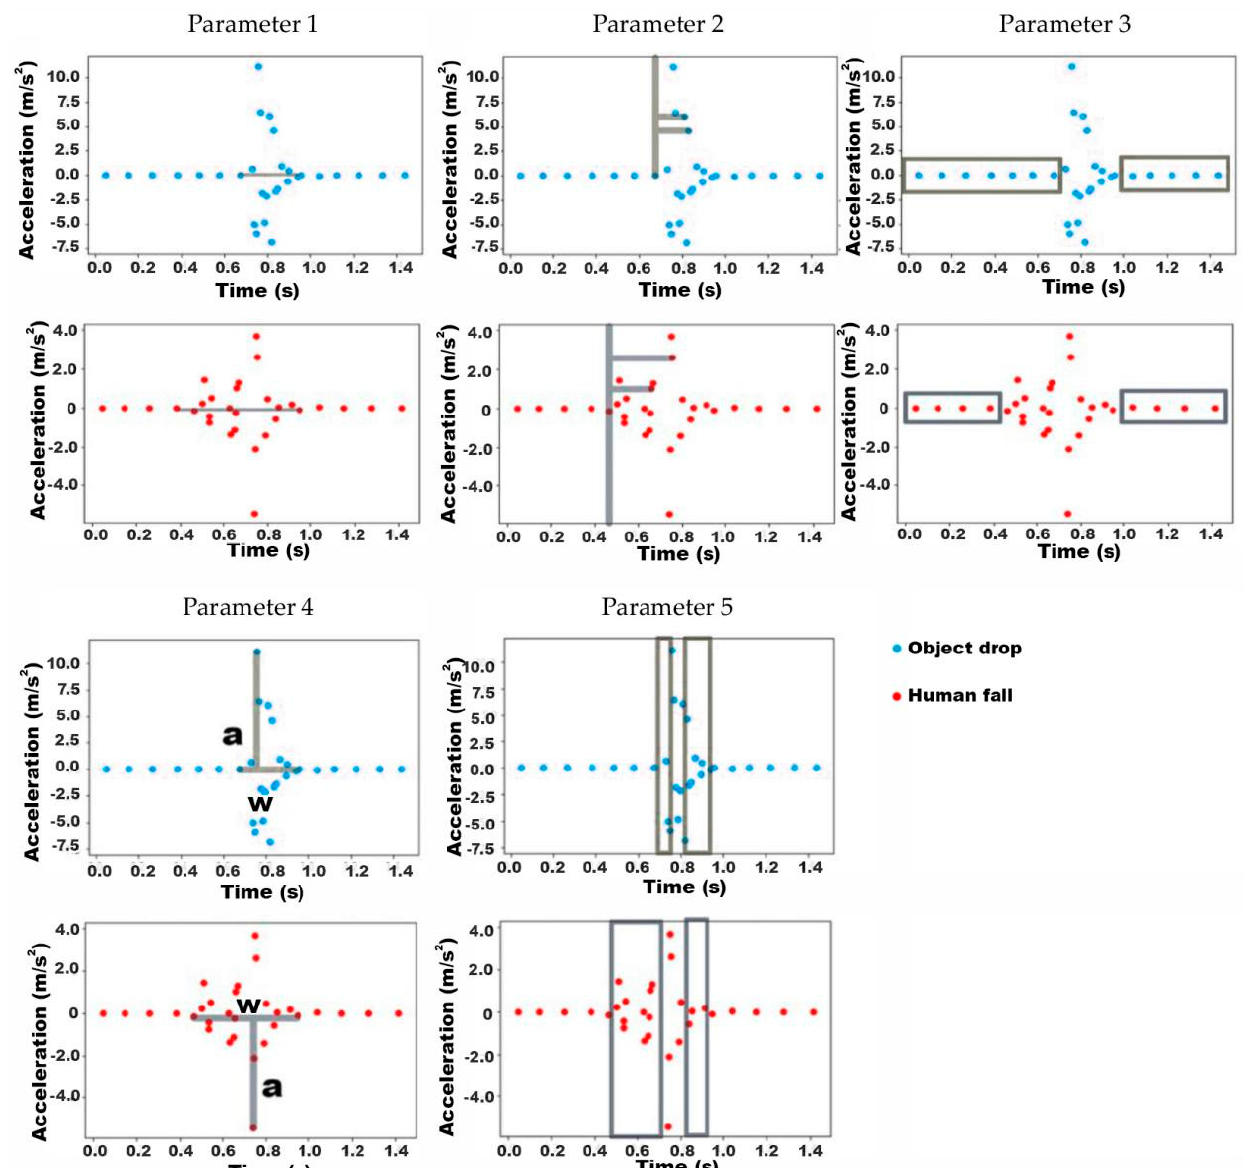
Figure 12. Extracted parameters of human fall and object drop.